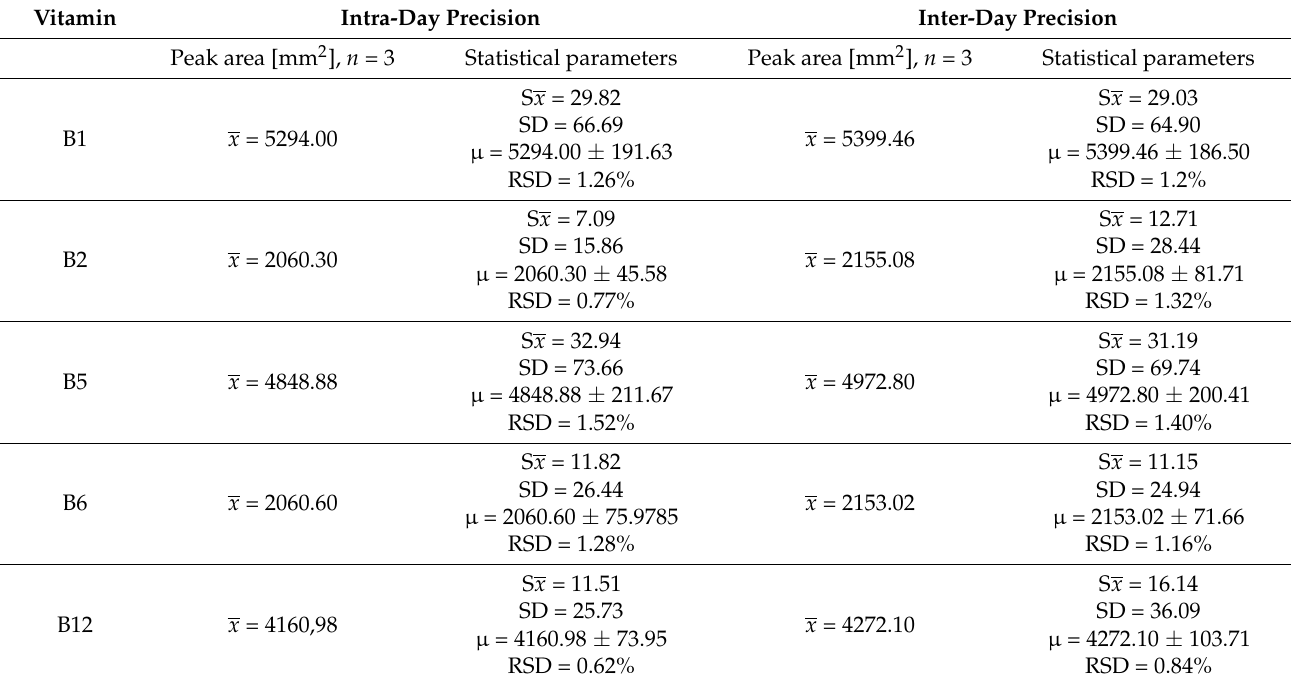
Table 2. The results of the inter- and intra-day precision of the determination of B vitamins with statistical